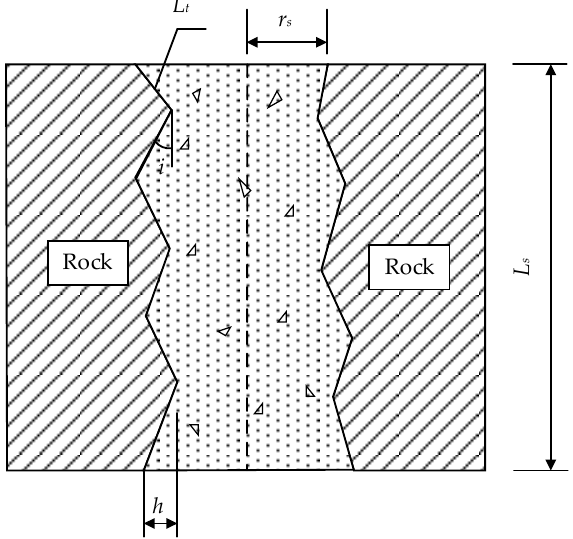
Figure 10. Schematic diagram of bore wall roughness of rock-socketed